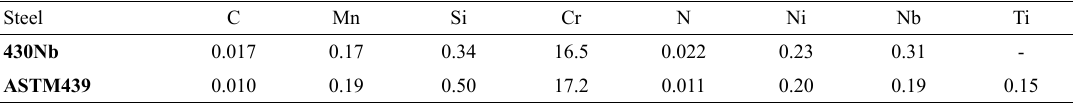
Table 1. Chemical compositions [wt%] of the investigated steels.